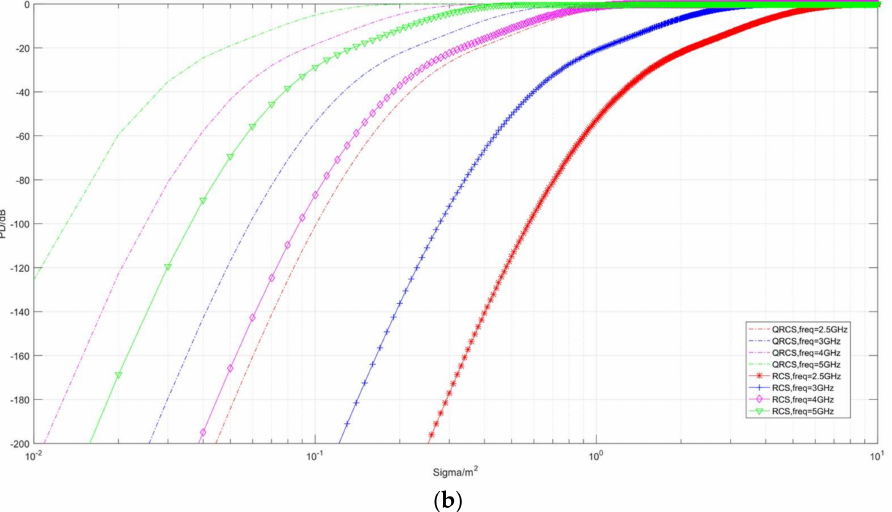
Figure 14. Correlation diagram of detection probability changing with RCS and QRCS (Taking different frequencies). ( a ) P D /%, ( b ) P D